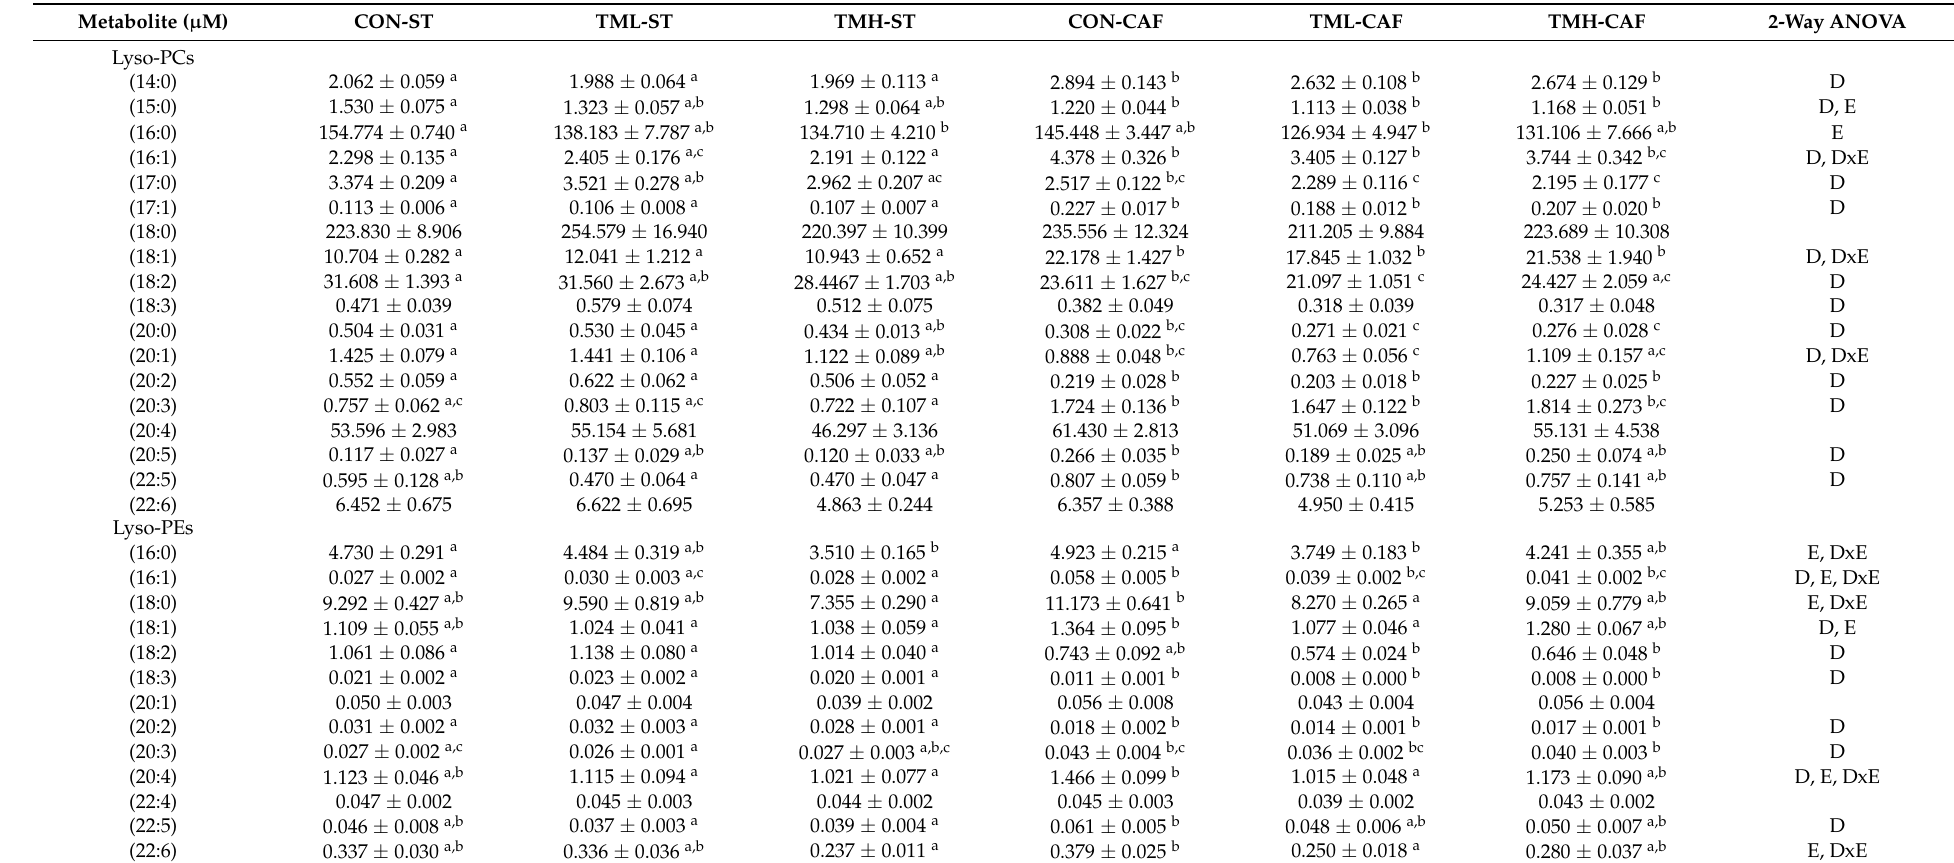
Table 1. Lysophospholipid levels in serum of rats fed a standard chow (ST) or a cafeteria diet (CAF) and periodically trained on a treadmill at different intensities (CON: 0; TML: 12; TMH: 17